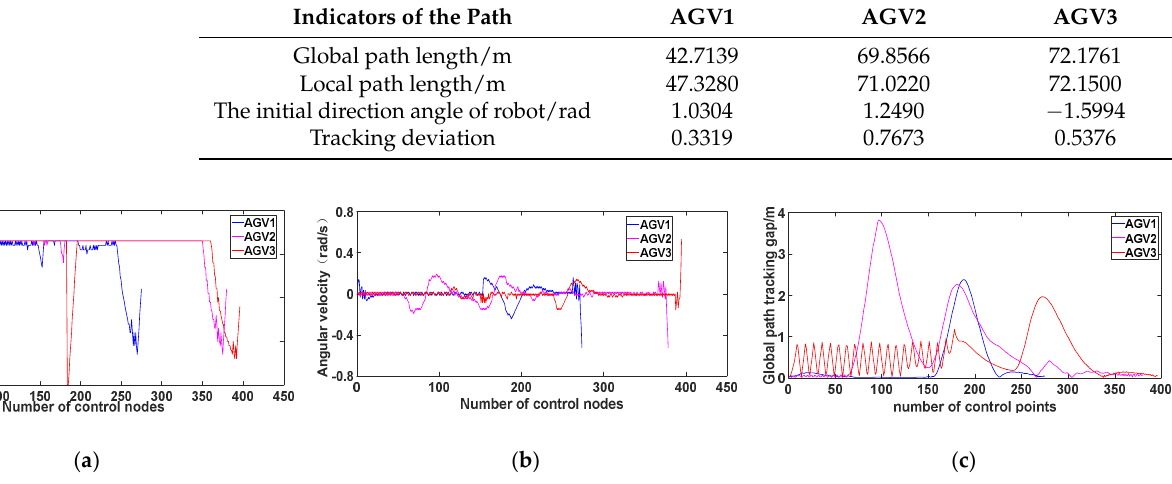
Figure 26. Multi−robot parameter comparison. ( a ) Comparison of linear velocity. ( b ) Comparison of angular velocity. ( c ) Comparison of tracking deviation. Table 9. Multi-robot path planning results in an unknown static marine environment.